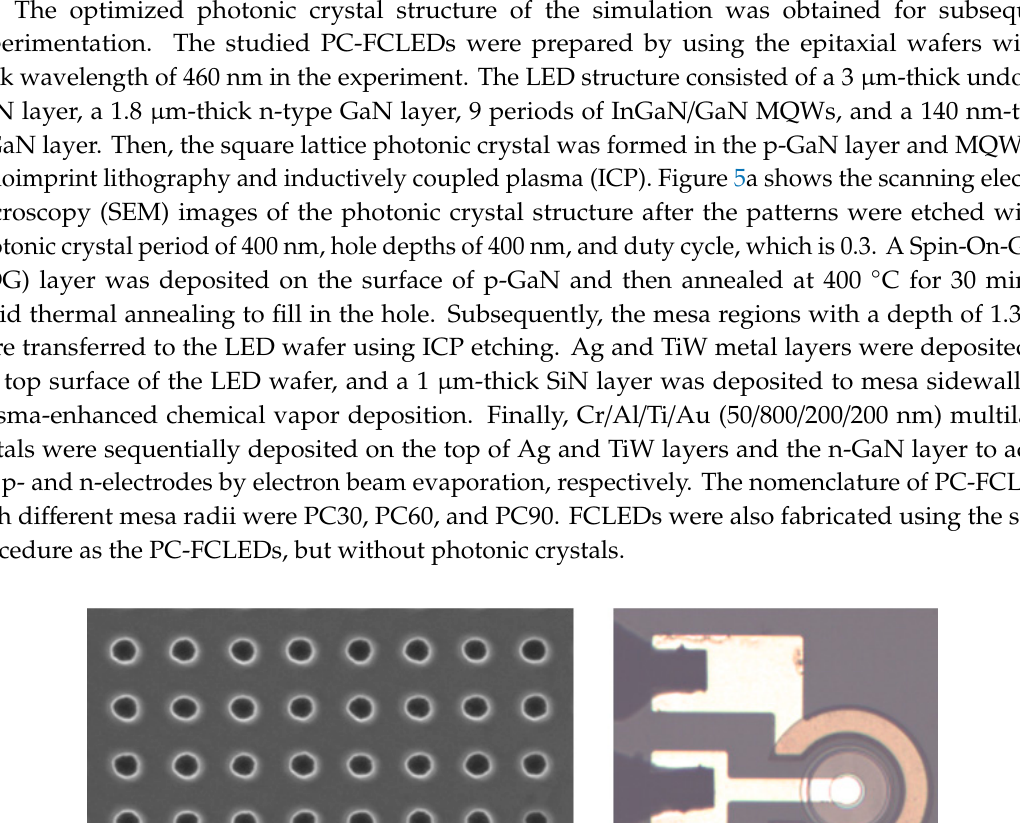
Figure 4. The tendency of ( a ) the Purcell factor and ( b ) LEE changing with the duty cycle and height of the photonic crystals when the photonic crystal period is fixed at 400 nm.